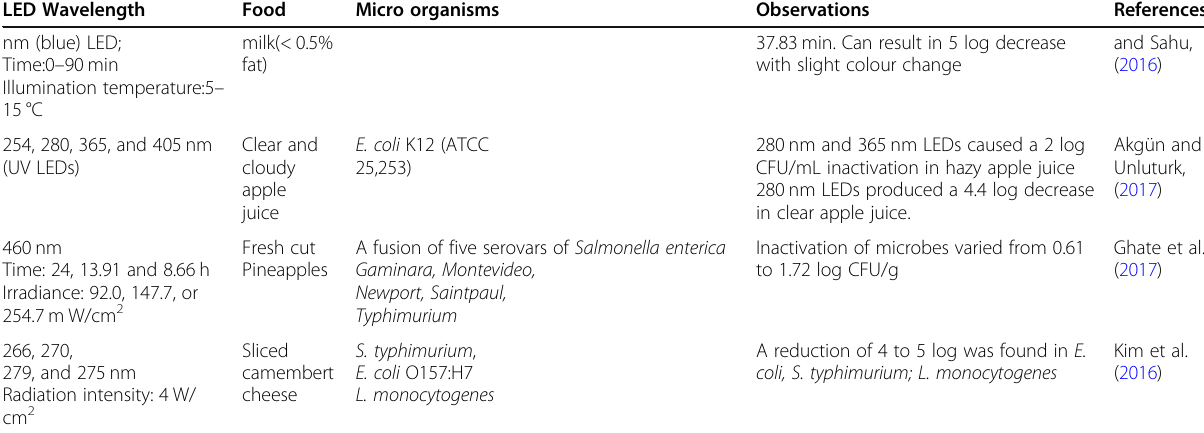
Table 2 Application of LED against various spoilage causing microorganisms in different food products (Continued) LED Wavelength